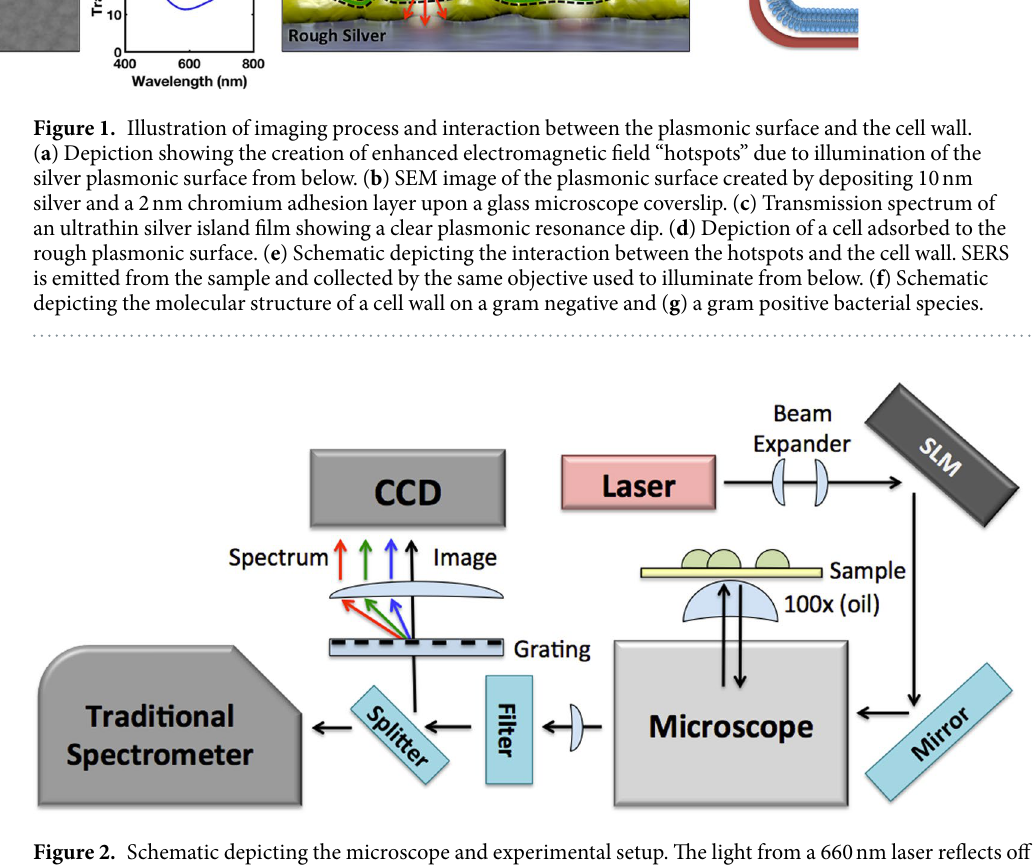
“speckle” profile was set to change roughly every 5 to 10 seconds during image acquisition, changing the hotspot distribution across the plasmonic surface, as depicted earlier in Fig. 1a. This produced more uniform hotspots